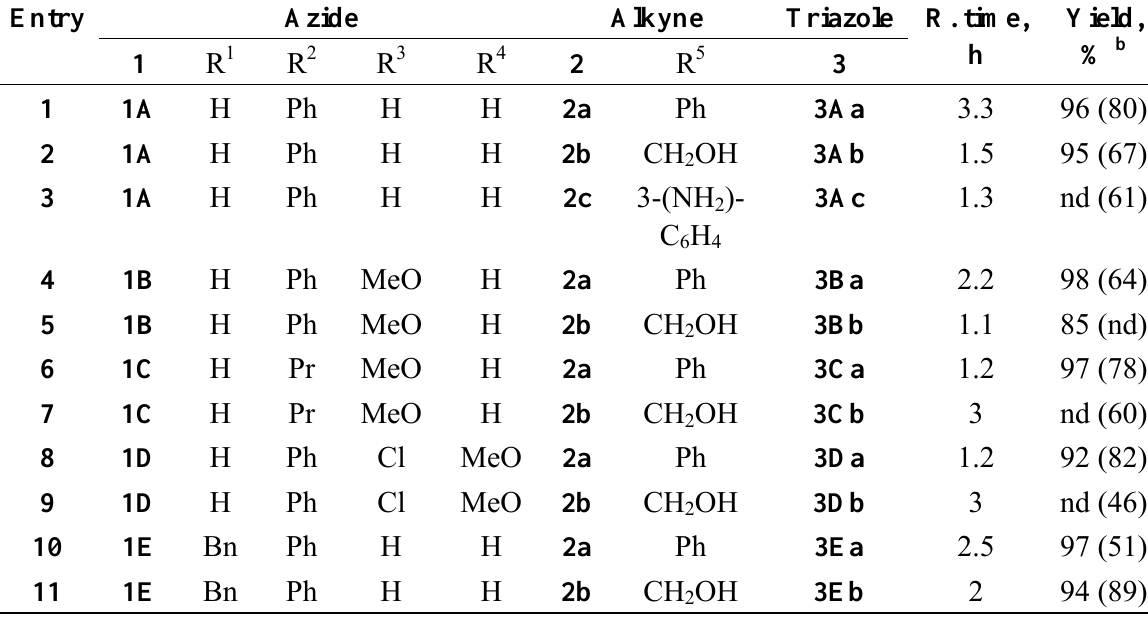
Table 1. Reaction conditions and yields for the formation of 1,2,3-triazoles 3 (Scheme 2) a . Entry Azide Alkyne Triazole R.